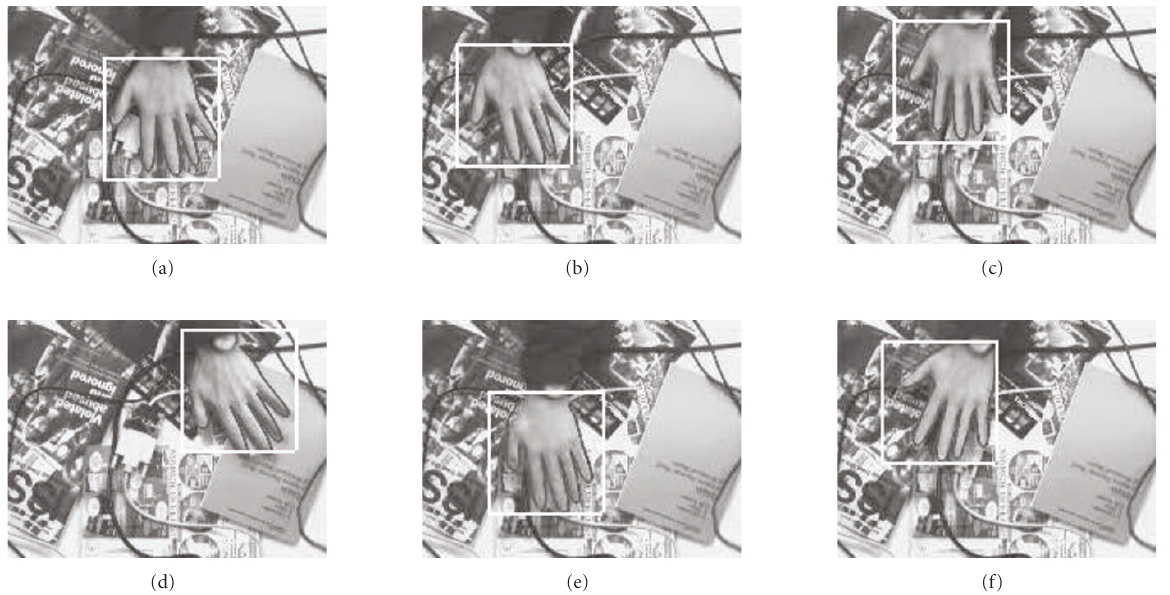
Figure 17: Tracking a hand moving on a cluttered table with Tracker D using both luminance and motion at time t = 16,29,37,53,66,78.